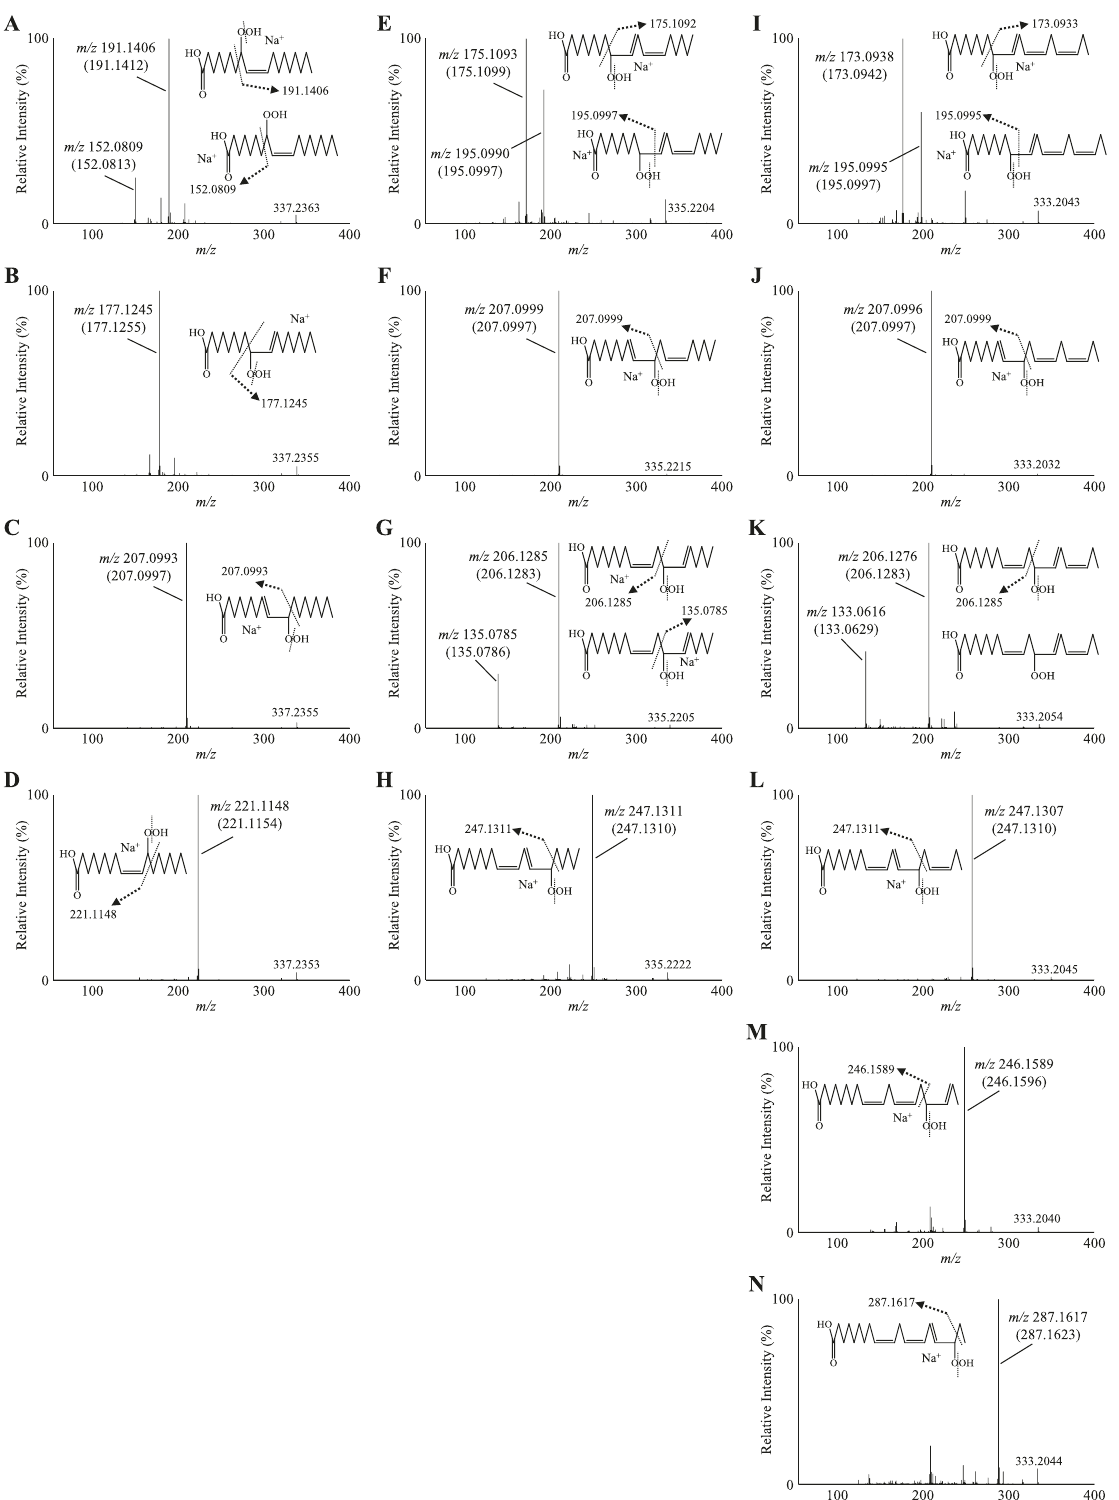
Fig. 2 Product ion mass spectra of FAOOH isomers. HpOME isomers ( m/z 337, A 8-HpOME; B 9-HpOME; C 10-HpOME; and D 11-HpOME), HpODE isomers ( m/z 335, E 9-HpODE; F 10-HpODE; G 12-HpODE and H 13-HpODE), and HpOTE isomers ( m/z 333, I 9-HpOTE; J 10-HpOTE; K 12- HpOTE; L 13-HpOTE; M 15-HpOTE; and N